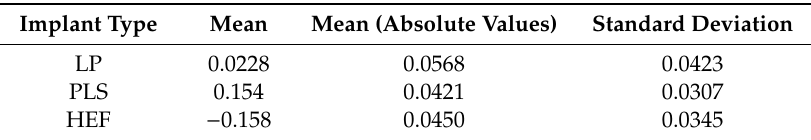
Figure 14. ID—actual values—ANN predicted values ( a ) and absolute error histograms ( b ). The mean value and standard deviation of error (absolute values) are presented in Table 5. Table 5. Mean and standard deviation of absolute error. Table 5. Mean and standard deviation of absolute error.